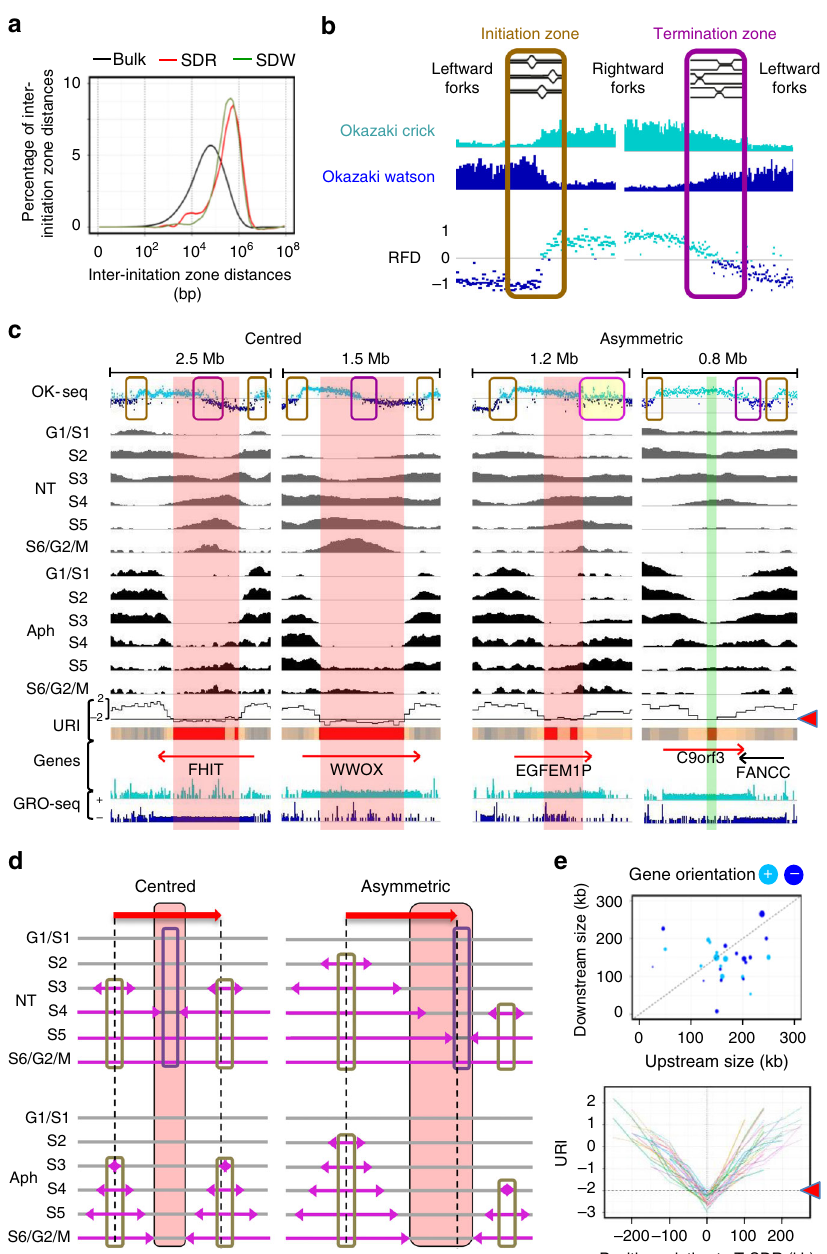
Fig. 2 T-SDR/SDW localization relies on the properties of fl anking initiation zones. a T-SDRs/SDWs are poor in initiation events. Percentage of inter- initiation zone distances identi fi ed by Bubble-Seq 30 for the bulk genome and regions overlapping SDRs or SDWs. The percentages were computed as in Fig. 1c with bin size = 0.1. b Determination of replication fork directionality (RFD) by Okazaki fragment sequencing (Ok-Seq). Each point shows the RFD value, computed (in 1 kb windows) as the difference between the proportions of forks moving rightward (fragments mapping on the Crick strand) or leftward (fragments mapping on the Watson strand). Upward (downward) transitions correspond to initiation (termination) zones 31 . c Representative examples of genes ≥ 300 kb (red arrows) displaying a centred (left panels) or an asymmetric (right panels) termination zone. The initiation and termination zones are highlighted by orange and purple boxes on the OK-Seq pro fi les, as in b , the yellow- fi lled box corresponds to a large zone showing complex RFD pattern with both initiation and termination events. Repli-Seq, URI and GRO-Seq pro fi les, and T-SDRs/SDWs, are as in Fig. 1f. From left to right, regions are chr3:59-61.5; chr16:77.9-79.5; chr3:167.6-168.9; chr9:97.4-98.2 Mb. d Scheme depicting how initiation poor regions nested in a large gene body elicit under-replication upon fork slowing. Pink arrows: replication forks. Red arrows and vertical dotted lines: genes. Initiation and termination zones, and the T-SDRs/SDWs are represented as above. Left: initiation zones with comparable fi ring times and ef fi ciencies fl ank the large gene. Right: the fl anking initiation zones display different fi ring time and localization relative to the 5 ′ - and 3 ′ -ends of the gene. e Upper panel: dot-plot showing the distances separating the transcription start site from the upstream end (Upstream size) and the transcription termination site from the downstream end (Downstream size) of the T-SDR ( n = 46). The circle sizes are proportional to the gene lengths. Genes on the + or – strand are indicated (light and dark blue, respectively). Lower panel: each colour line shows the URI pro fi le of the upstream and downstream (negative and positive values on the x axis, respectively) regions fl anking each individual T-SDR. Source data are provided as a Source Data fi